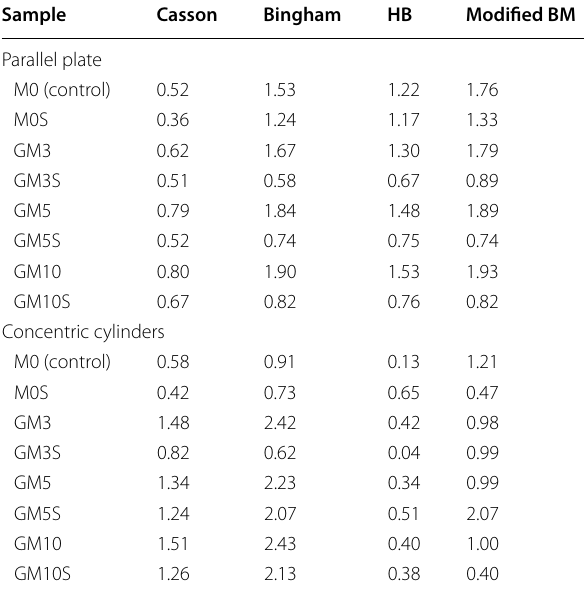
Table 8 Effect of super-plasticizer on yield stress